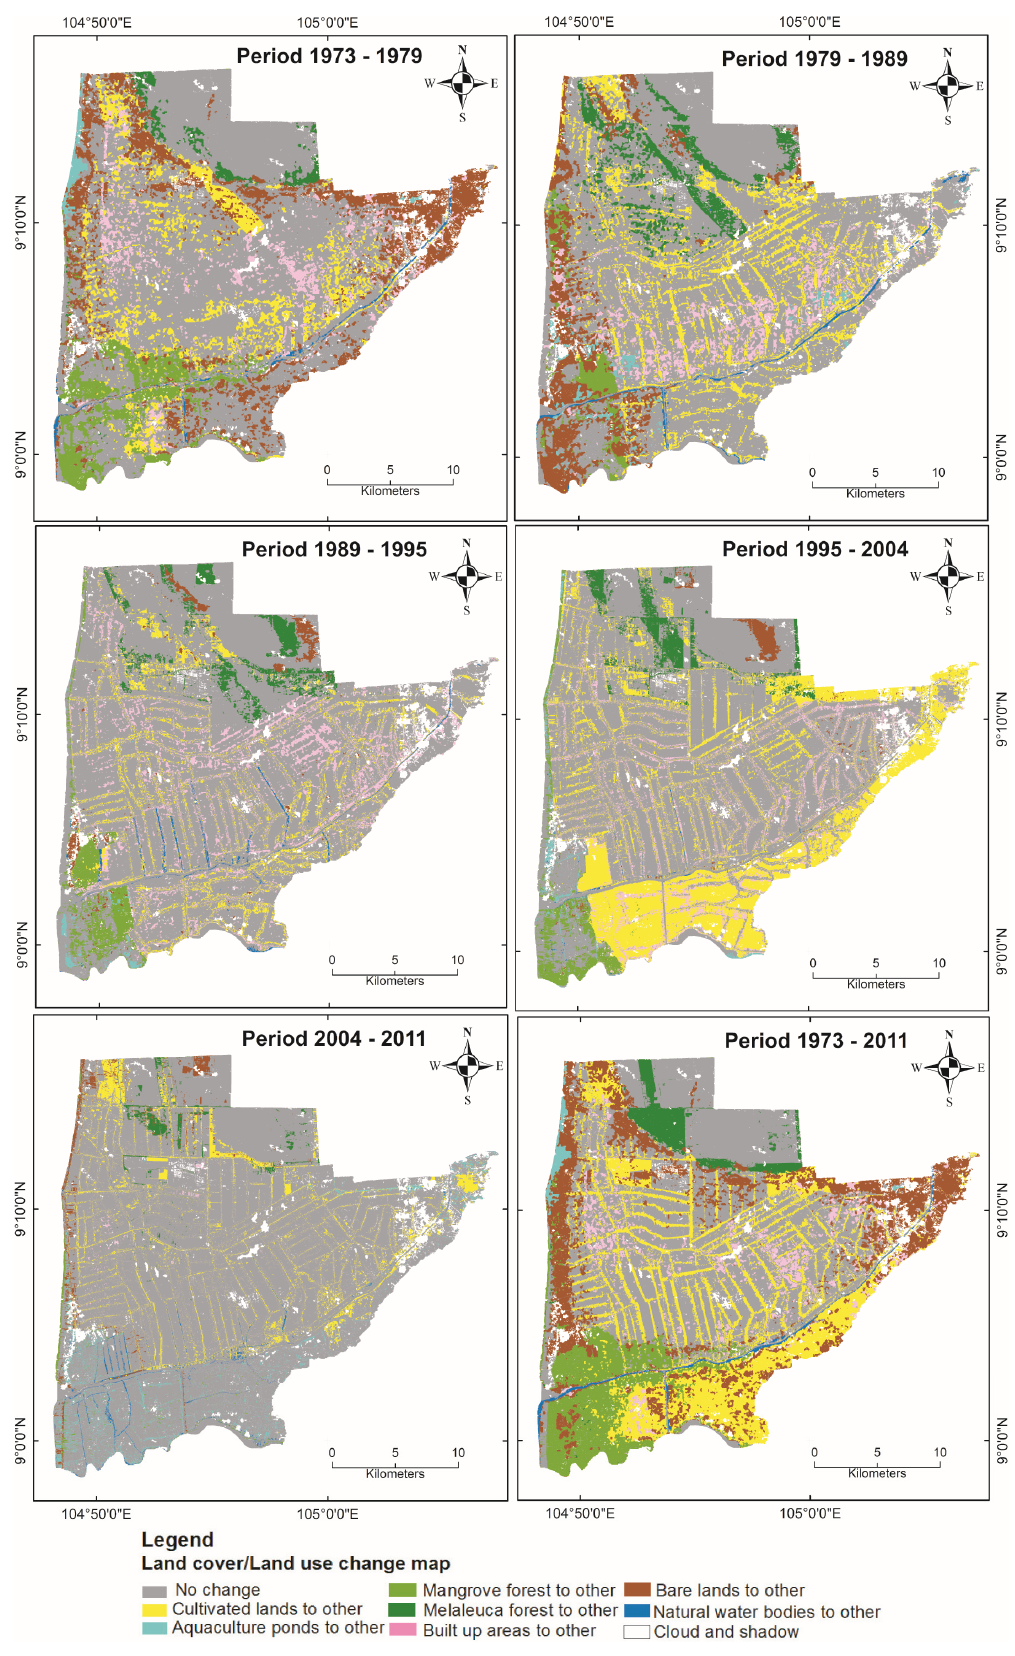
Figure 8. Spatial distribution of land cover/land use changes in the Tran Van Thoi District from 1973 to